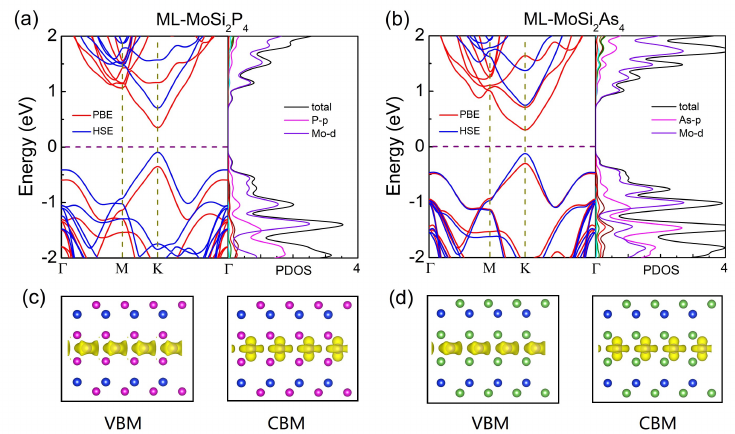
Figure 4. The electronic band structure and projected density of states (PDOS) of monolayer ( a ) MoSi 2 P 4 and ( b ) MoSi 2 As 4 . ( c , d ): Corresponding charge distribution at valence band maximum (VBM) and conduction band minimum (CBM) dominated by the d orbital of Mo atoms in the middle